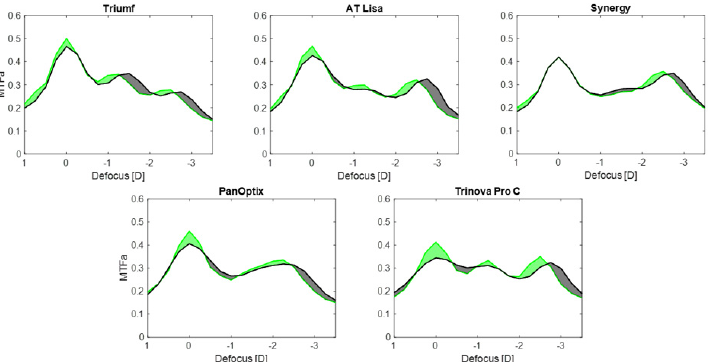
Figure 2. The area under the modulation transfer function (MTFa) of the studied IOLs: from measurements obtained at 3 mm and a defocus range from +1 D to − 3.5 D. Monochromatic light with an aberration-neutral corneal model was applied in Condition 1 (green lines), and polychromatic light with a population level of corneal spherical aberration in Condition 2 (black lines). Green-shaded areas indicate an improved MTFa in Condition 1 over Condition 2, and black-shaded areas denote a higher optical quality in Condition 2.